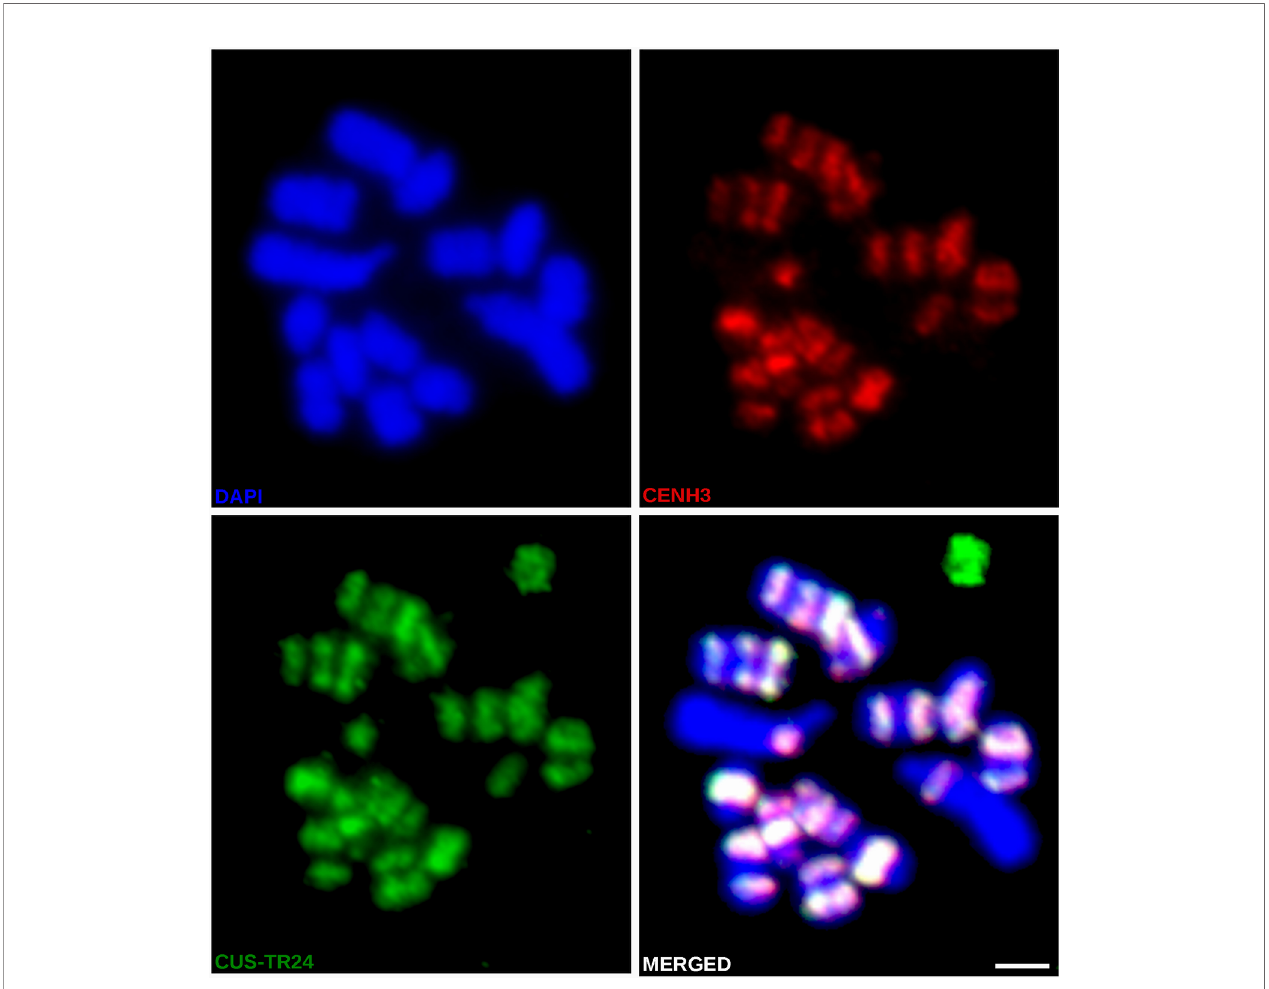
FIGURE 5 | Simultaneous immuno-FISH detection of CENH3 and CUS-TR24 on metaphase chromosomes of C. europaea . CENH3 (red) was detected using mixed antibodies against CENH3 CEURO-1a/b and CENH3 CEURO-2 . CUS-TR24 and DAPI-stained chromosomes are shown in green and blue, respectively. Scale bar = 2